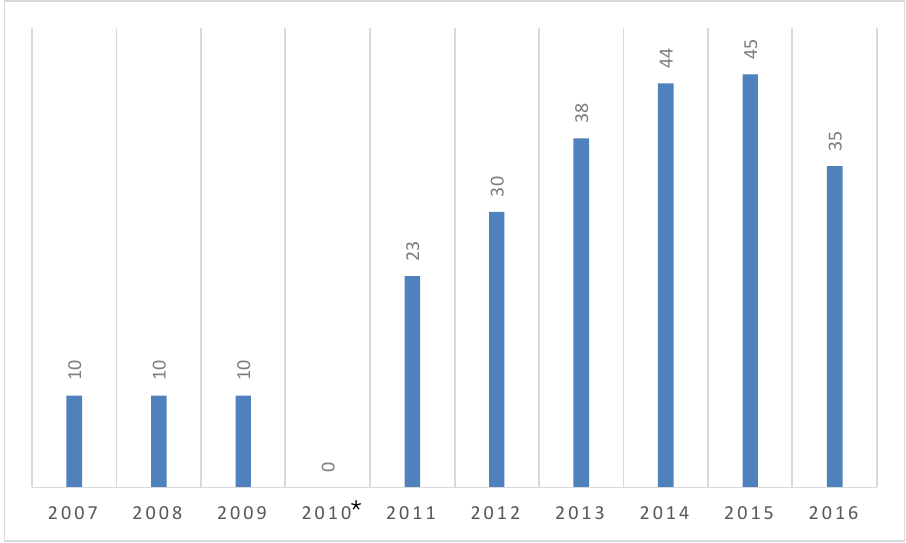
FIGURE 1: Number of articles published per year Source: Journal of Economic and Financial